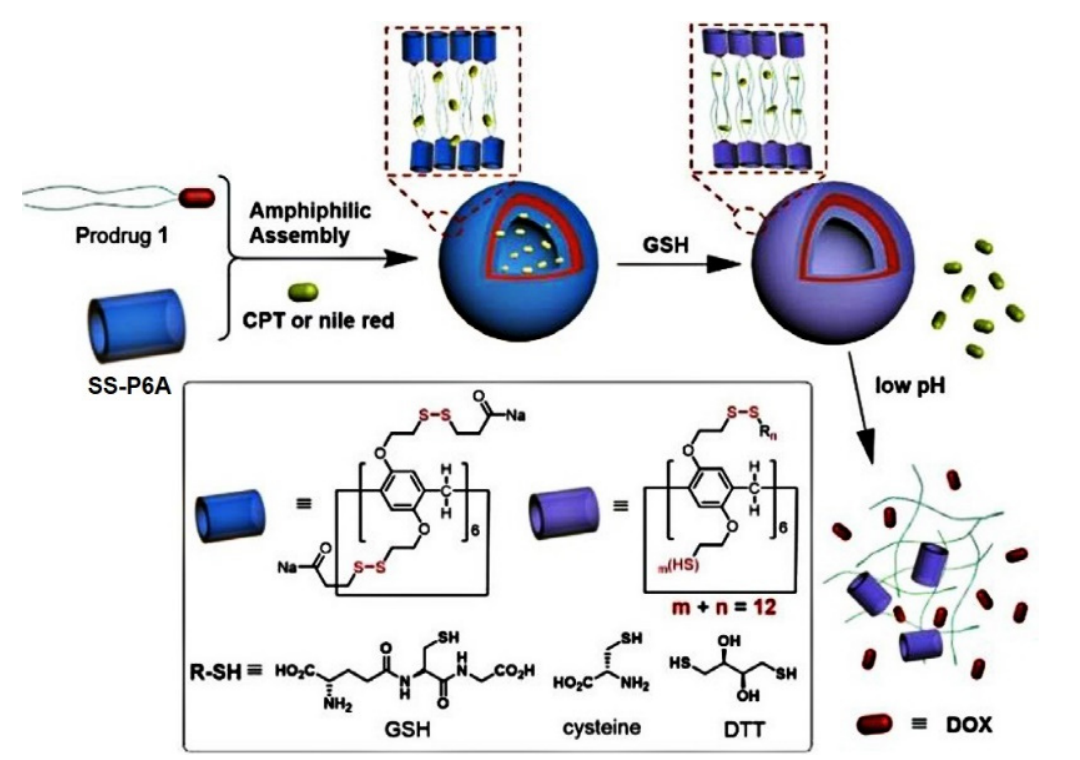
Figure 9. Schematic illustration for the formation of supramolecular vesicles and GSH/acid-induced sequential cargo release. Reproduced with the permission of reference [86]. Copyright © Elsevier 2022.